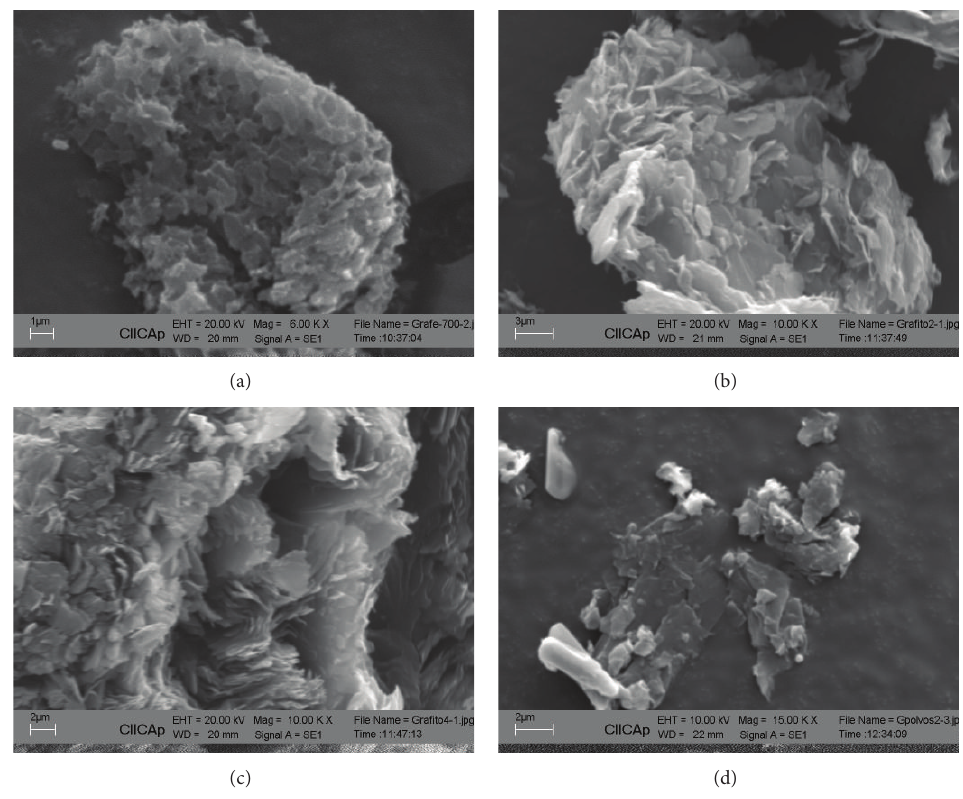
Figure 3: SEM images of MEG under thermal treatment at 700 ∘ C with temperature and in different solutions with ultrasound: (a) treated to 700 ∘ C, (b) treated to 700 ∘ C and formic acid, (c) treated to 700 ∘ C and KOH :NaOH 1M (1:1), and (d) treated to 700 ∘ C and H 2 O 2 .